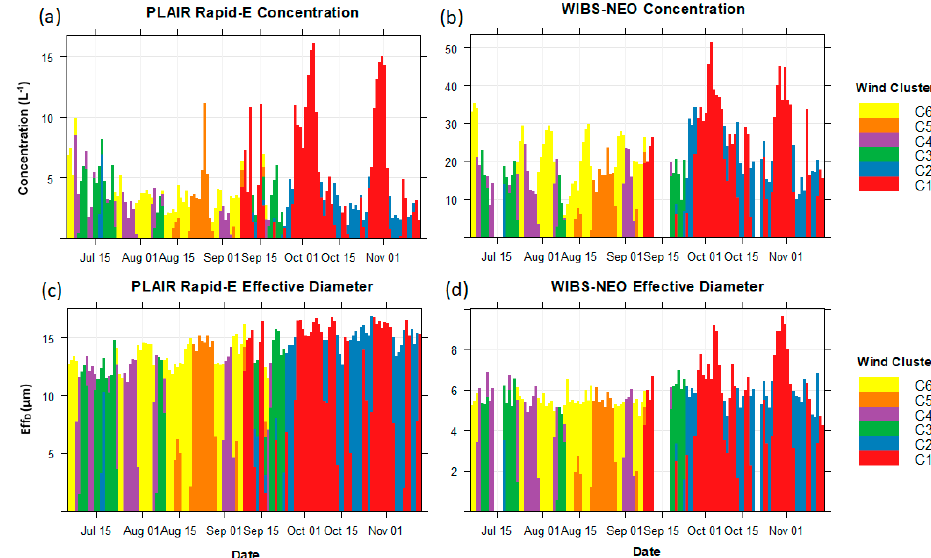
Figure 6. Average daily concentrations (L − 1 ) and effective diameter (µm) of particles detected by both the PLAIR Rapid-E and WIBS-NEO, as a function of wind cluster. Panels ( a ) and ( b ) represent PLAIR Rapid-E and WIBS-NEO concentrations, respectively. Panels ( c ) and ( d ) represent PLAIR Rapid-E and WIBS-NEO Effective Diameter, respectively. Concentrations recorded by the WIBS-NEO are for particles across the instrument’s entire size range (0.5–30 µm).